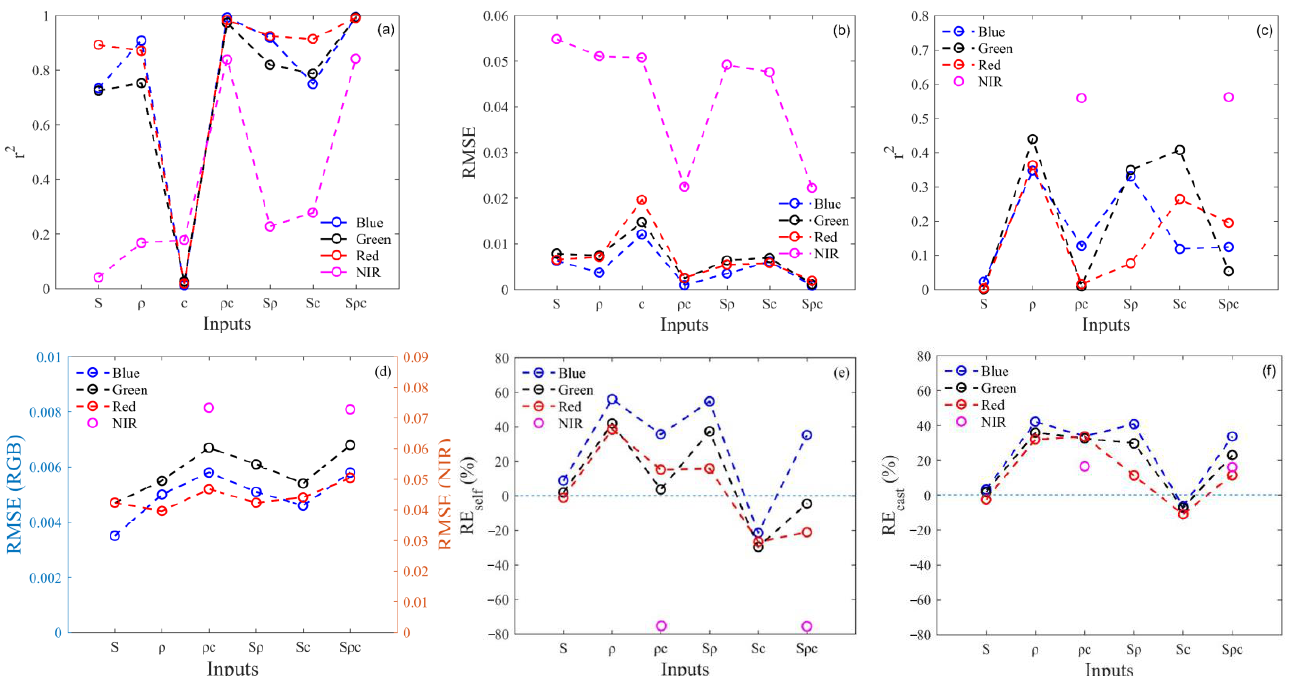
Figure 6. The training accuracy ( a , b ) and the forecasting accuracy ( c – f ) of the RGB and NIR wave- bands: ( a ) coefficient of determination ( r 2 ) of training accuracy, ( b ) root mean squared error (RMSE) of training accuracy, ( c ) r 2 of waveband reflectance vs. cos i , ( d ) RMSE of waveband reflectance vs. cos i , ( e ) reflectance relative error between the self-shadow and the sunny area (RE self ), and ( f ) reflectance relative error between the cast shadow and the sunny area (RE cast ). S, ρ , and c represent the ITC with input of SEVI, surface reflectance, and cos i , respectively.